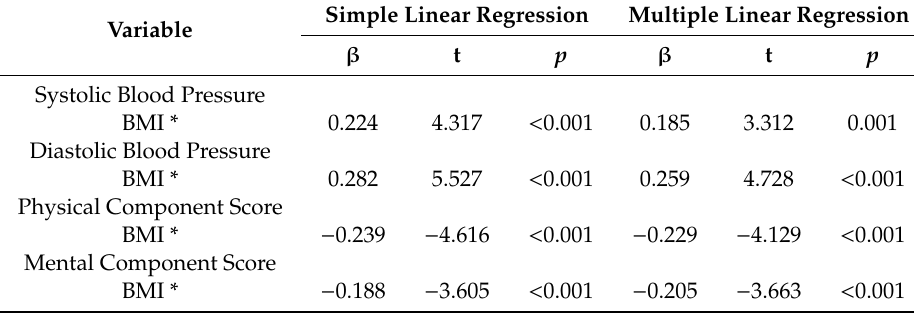
Table 4. Contributions of BMI towards blood pressure and quality of